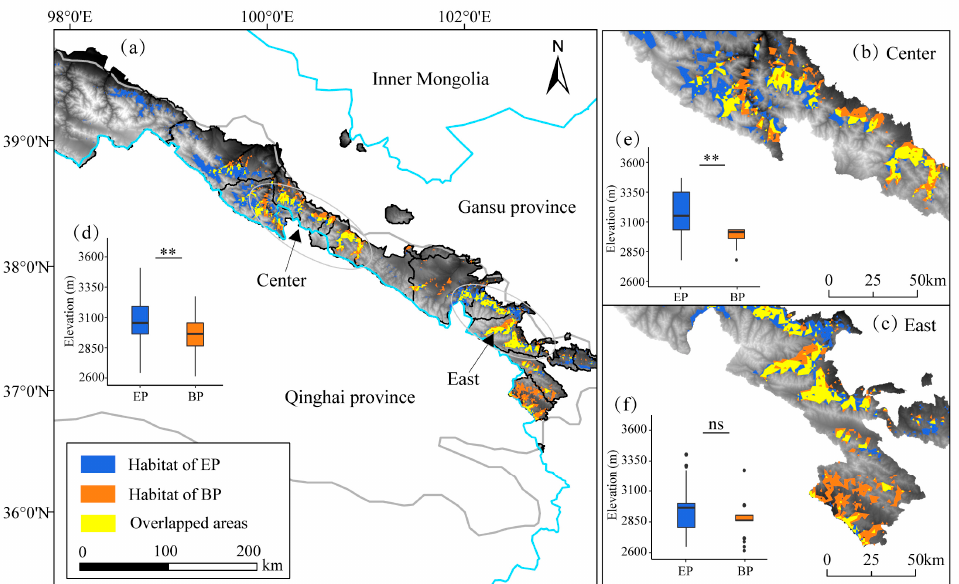
Figure 3. The spatial distribution pattern of EP and BP in the QMNNR, Northwestern China. ( a ) Potentially suitable habitat and overlap of both species in horizontal space are shown by modeling. ( b , c ) Higher resolution maps of concentrated areas of overlap in the middle and eastern sections in the QMNNR, as shown in ( a , d – f ) indicate their vertical spatial distribution in the QMNNR, Middle and East of the QMNNR based on the records by camera traps, respectively. The double star indi- cates that the differences were significant at the p = 0.01 level based on the Wilcoxon test.